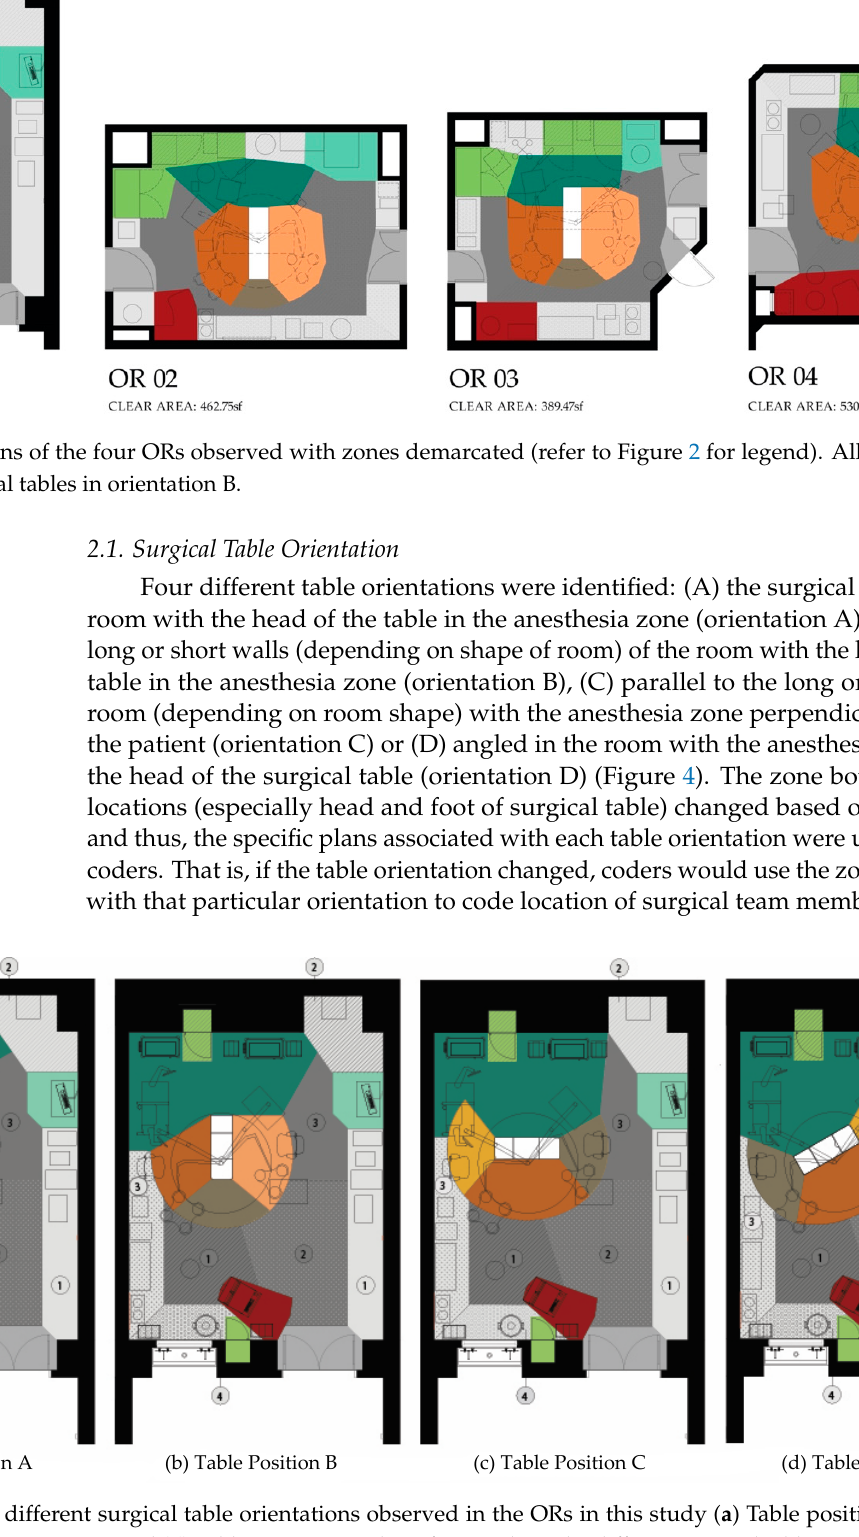
Figure 2. Location and type of zones in the ORs.